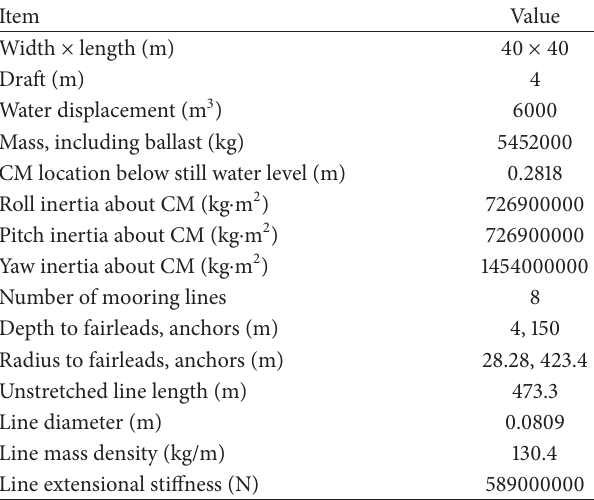
Figure 6: Mooring line geometry with nondimensional tension.